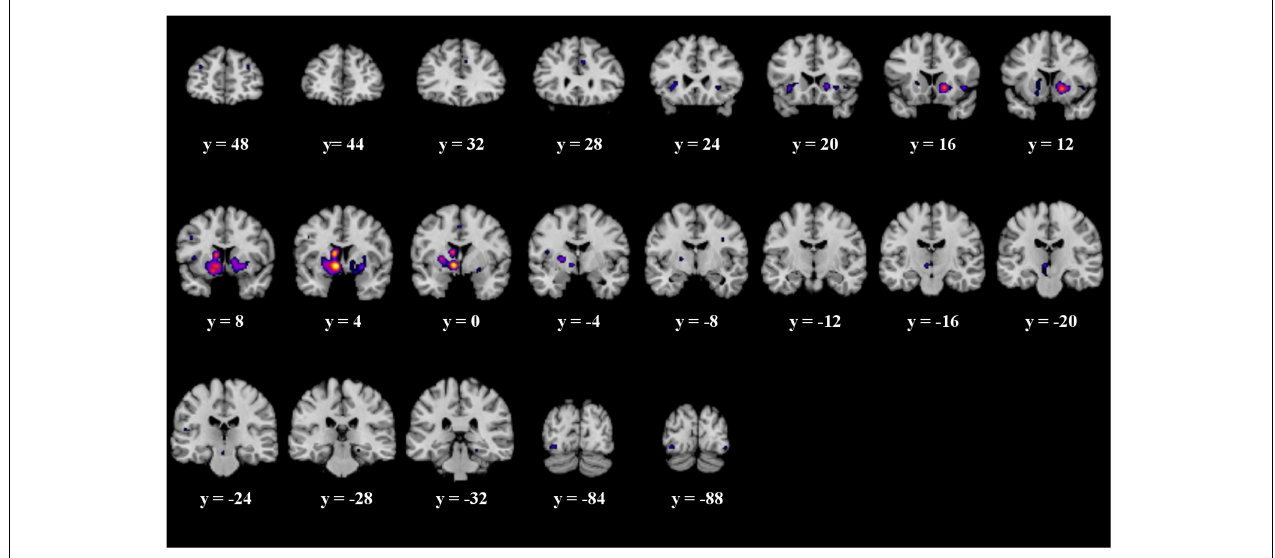
FIGURE 3 | Overview of the meta-analysis results for the studies reporting active behavioral paradigms ( p < 0.05, FDR). The significant clusters are comprised of activity in the superior frontal gyrus, middle frontal gyrus, anterior cingulate, cingulate gyrus, claustrum, insula, caudate head, inferior frontal gyrus, caudate body, putamen, medial globus pallidus, thalamus, substancia nigra, red nucleus, transverse temporal gyrus, parahippocampal gyrus, fusiform gyrus and inferior occipital gyrus (from left to right). MNI coordinates are presented below each coronal